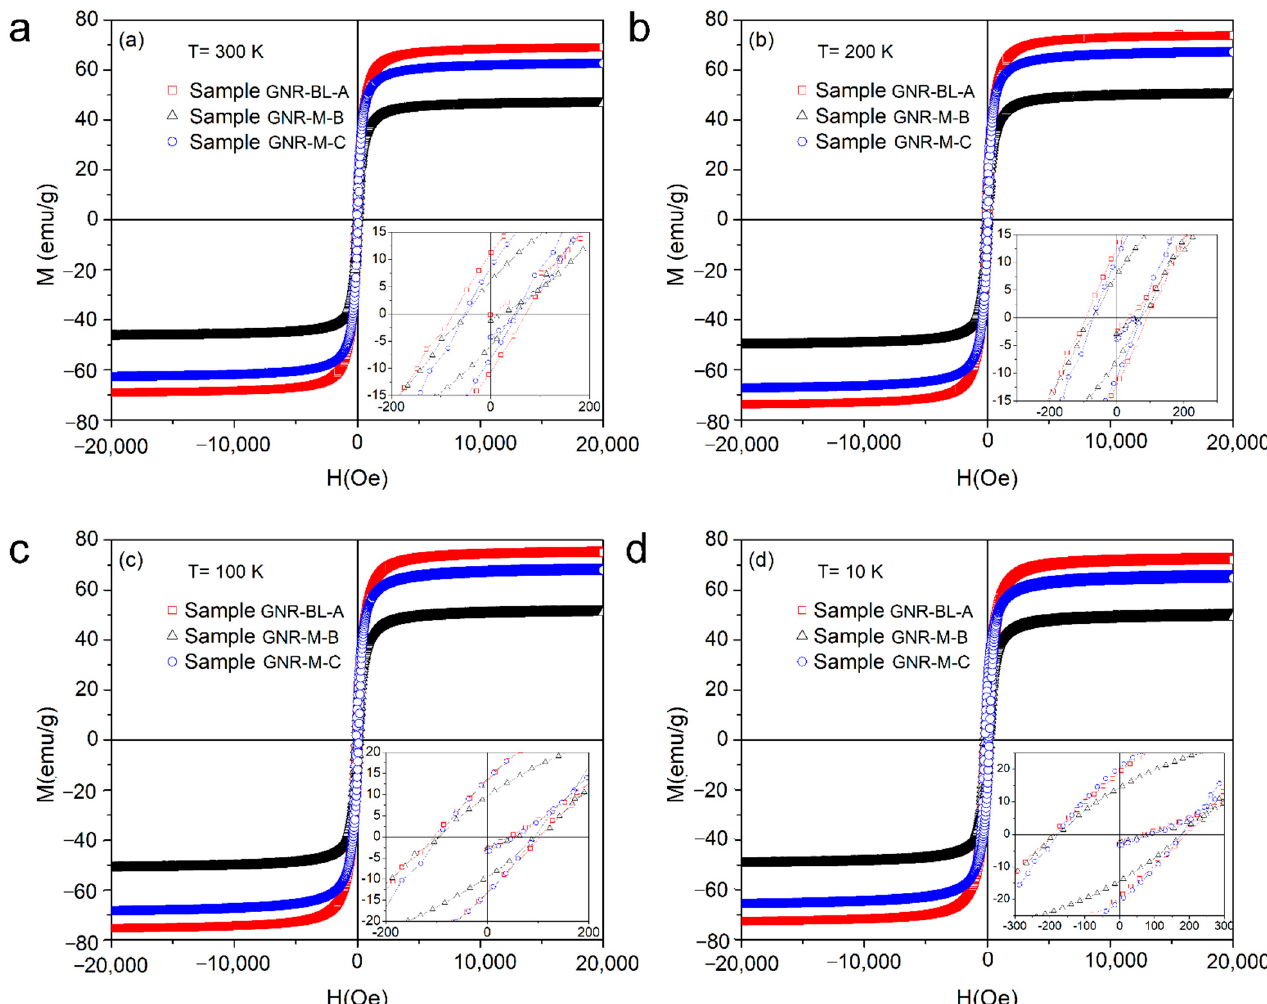
Figure 9. Magnetization as a function of the applied magnetic field at ( a ) 300 K, ( b ) 200 K, ( c ) 100 K, and ( d ) 10 K for samples of black and magnetic solids obtained in the long-term enrichment cultures of GNR-BL-A (red squares), GNR-M-B (black triangles), and GNR-M-C (blue circles). Inserts show the hysteresis curve for low magnetic field values, where it is possible to observe the coercive field and the remanent magnetization. See Table 1 for detailed information on the sam- ples.